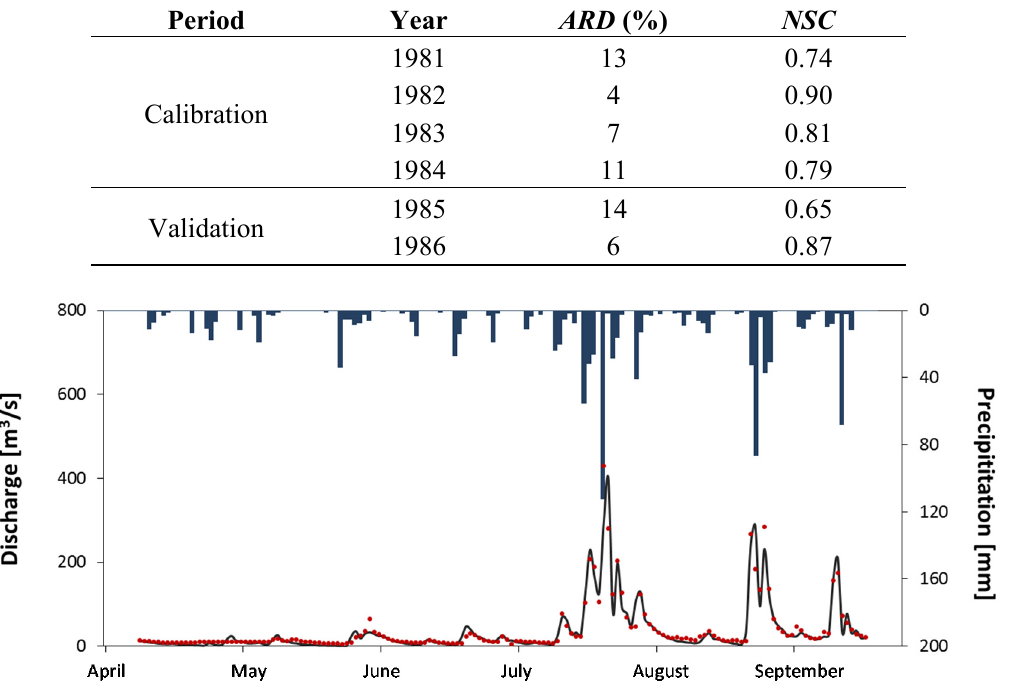
Table 1. Performance of the Grid-Xinanjiang model for the calibration and validation periods.